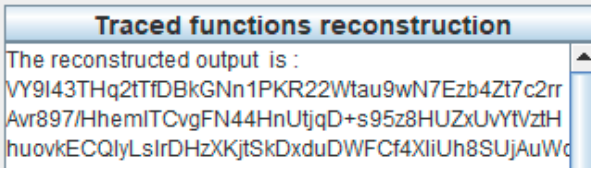
Figure 35. Reconstructed output of traced cryptographic functions.